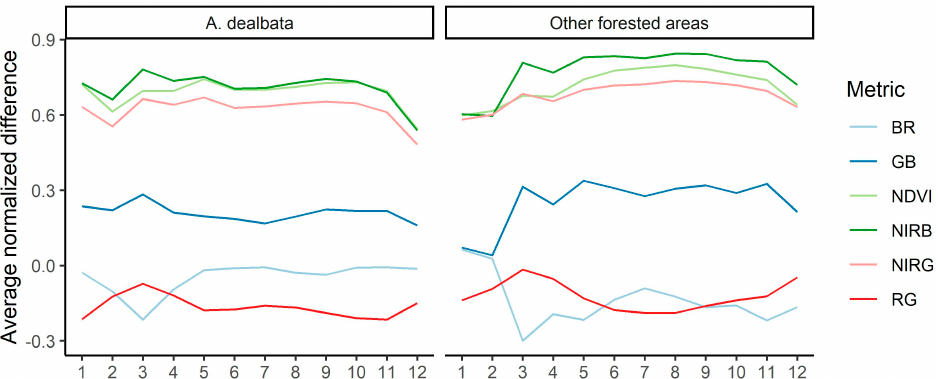
Figure 3. Average monthly ND values for the analyzed Sentinel-2 time-series (2018–2022). Abbrevia- tions: BR refers to the normalized difference (ND) between blue and red; GB is the ND between green and blue; NDVI is the normalized difference vegetation index; NIRB refers to the ND between NIR and Blue; NIRG is the ND between NIR and green; and RG refers to the ND between red and green.